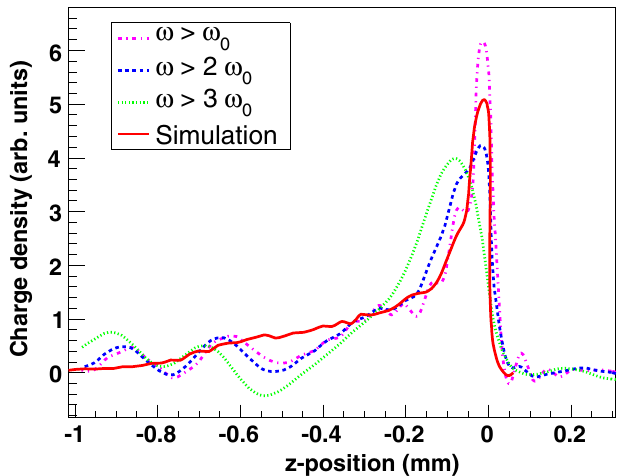
FIG. 7. (Color) Variations of the longitudinal charge distribution due to intensity spectrum-completion procedure at high frequen- cies. The intensity spectrum at large frequencies was completed by fitting the asymptotic power function with data points from different frequency ranges. The best agreement with simulations . Experimental and simulation results is achieved for ! > 2 ! 0 were obtained for 3.2 nC electron bunches at moderate com-